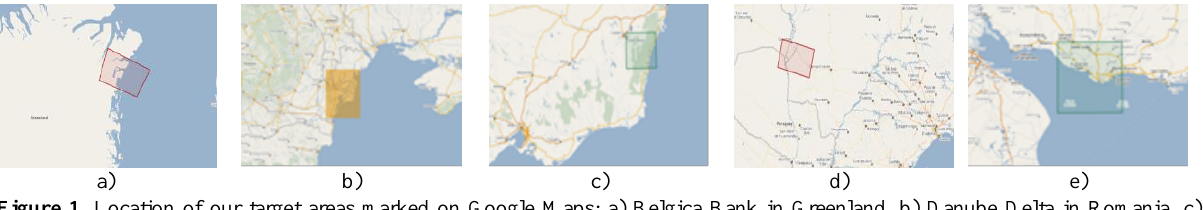
Figure 1 . Location of our target areas marked on Google Maps: a) Belgica Bank in Greenland, b) Danube Delta in Romania, c) Sydney in Australia, d) Amazon rainforest between Brazil, Bolivia, and Paraguay, and e) Montevideo in Uruguay.